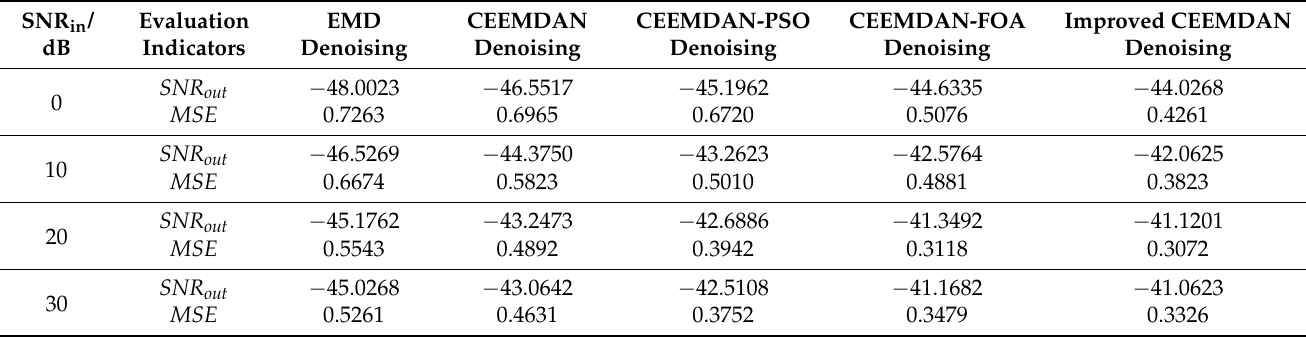
Table 1. SNR out and MSE of different denoising methods.